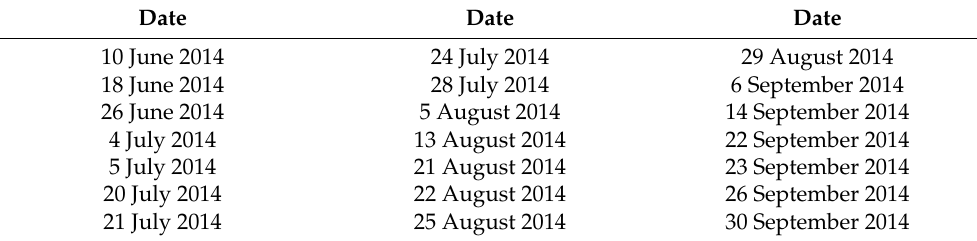
Table 1. Iqaluit COSMO-SkyMed acquisition dates.